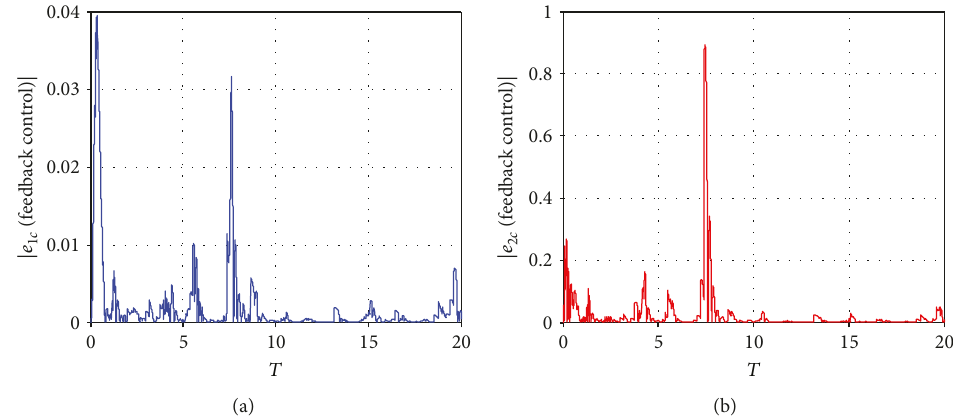
Figure 8: Deviation of the desired trajectory with the proposed control with parametric errors in feedback control u : (a) deviation of the = u − u u desired trajectory e 1 1 c 1 c and (b) deviation of the desired trajectory e 2 c c